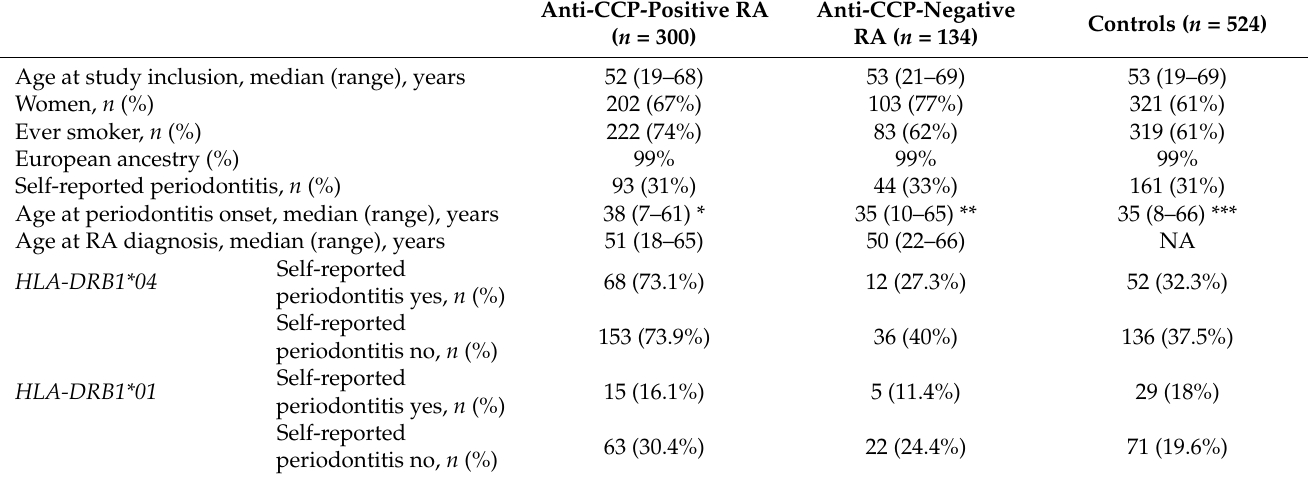
Table 1. Demographic and clinical characteristics of anti-citrullinated protein antibody (anti-CCP)- positive and anti-CCP-negative rheumatoid arthritis (RA) and non-RA controls. Anti-CCP-Positive